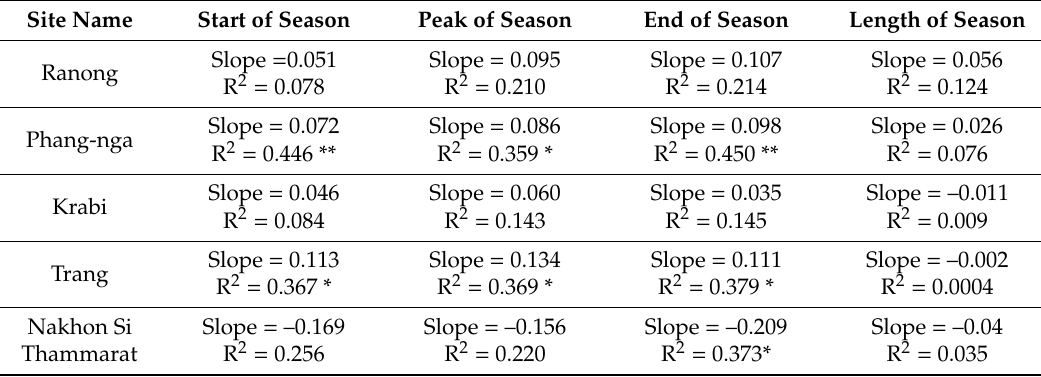
Figure 11. Inter-annual change variations in mangrove phenology at five study sites, ( a ) SOS, ( b ) POS, ( c ) EOS and ( d ) LOS. The dashed line is linear fitting. Table 2. Trend analysis of mangrove phenology at the five study